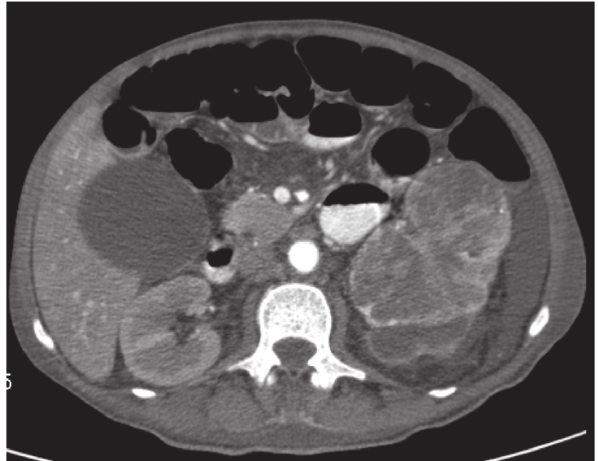
Figure 1: Computed axial tomography of the abdomen with in- travenous administration of iodinated contrast: centered on the lower two-thirds of the left kidney, neoformative mass with het- erogeneous enhancement, and some areas of liquefaction with greater longitudinal anteroposterior and transversal axis evaluated as 10.5 × 11.7 × 8.5cm, respectively.